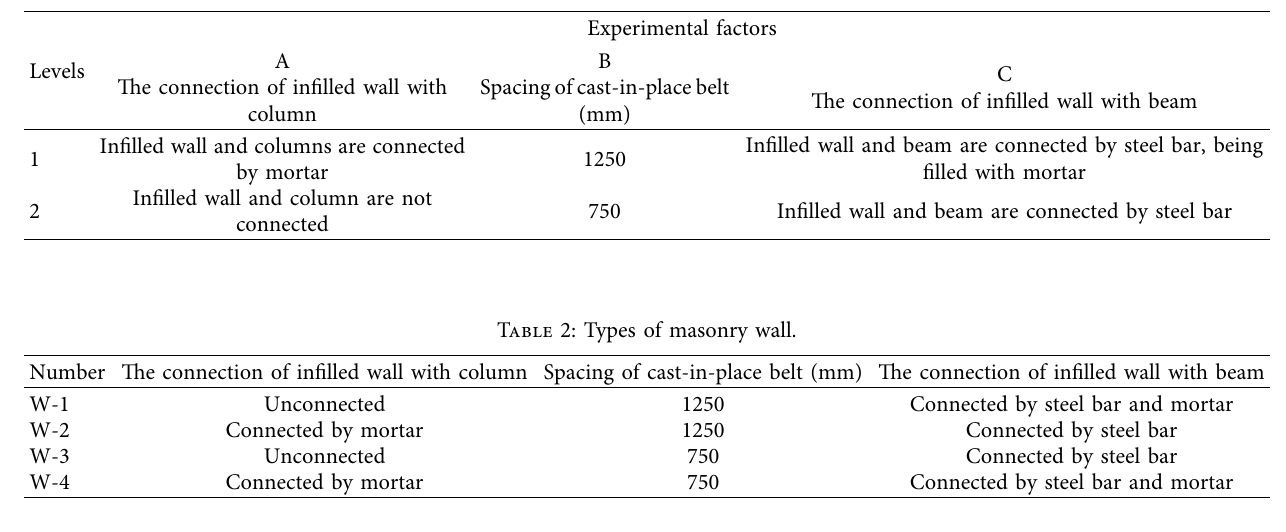
Table 1: Orthogonal experiment list.